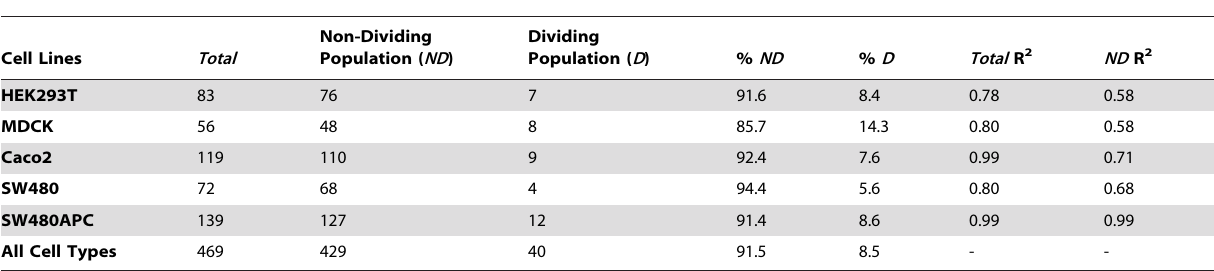
Table 1. Statistics for cell population identification and isolation.